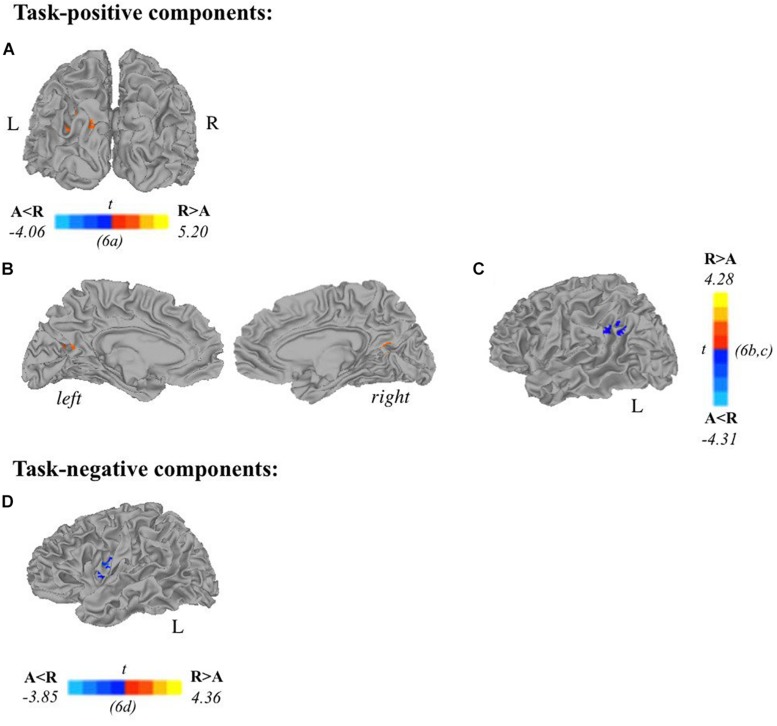
Relationships between handedness and task-related components. Two-sample t-tests reveal differences between atypically handed and right-handed individuals in task-positive components (A–C) and task-negative components (D). In terms of spatial extent of task-related activation, atypical-handers and right-handed individuals recruited additional regions during active encoding: (A) left cuneus, (B) posterior cingulate cortex, (C) left angular gyrus; and during passive encoding: (D) left insula. Orange depicts areas where atypical-handers task-related extent was greater than right-handed individuals, and blue depicts areas where right-handed individuals task-related extent was greater than atypical-handers (A, atypical-handed; R, right-handed; p < 0.05 corrected).